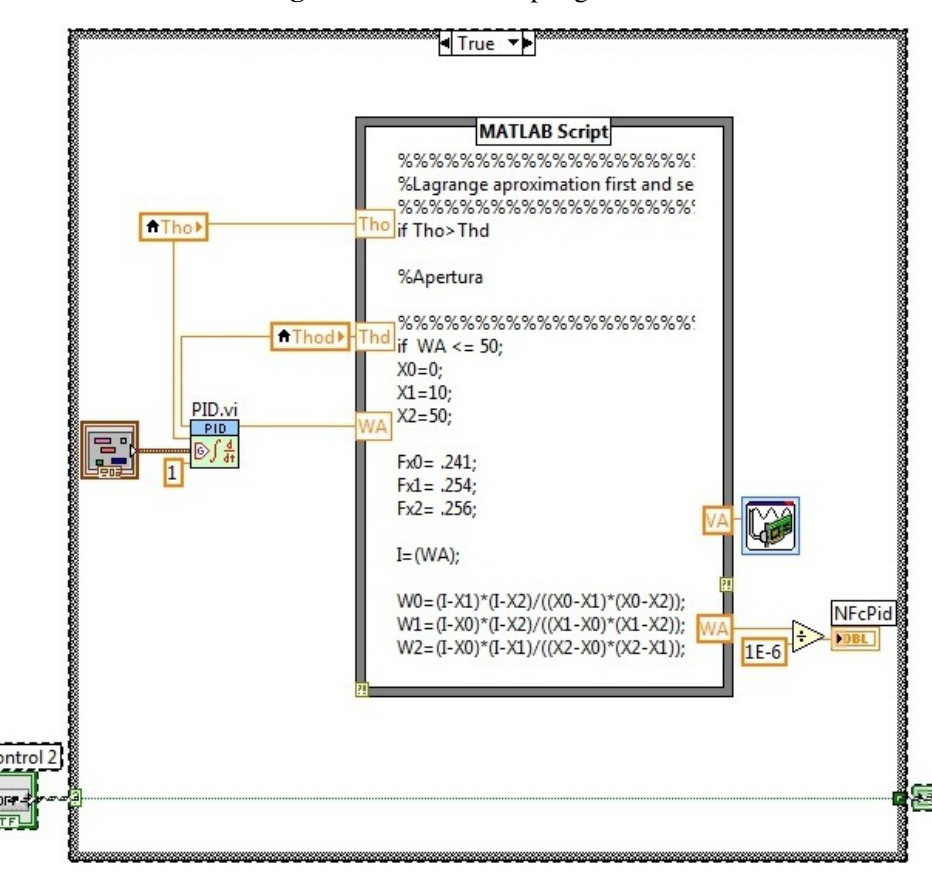
Figure 15. Closed loop